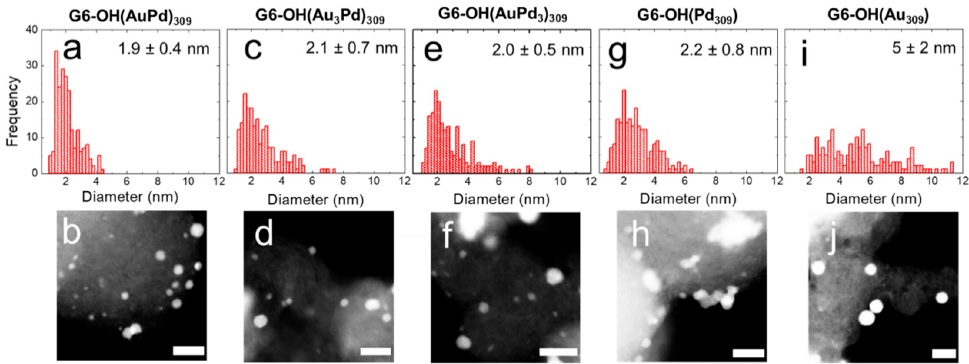
Figure 6. Size ‐ distribution histograms and ac ‐ STEM micrographs for conductive inks containing ( a , b ) G6-OH(AuPd) 309 ; ( c , d ) G6-OH(Au 3 Pd) 309 ; ( e , f ) G6-OH(AuPd 3 ) 309 ; ( g , h ) G6-OH(Pd 309 ); and ( i , j ) G6-OH(Au 309 ) DENs after electrocatalytic EOR CAs. CAs were carried out in a N 2 -satd., 1.0 M KOH solution containing 0.50 M ethanol, by holding the electrode potential for 1.0 h at the peak potential of the forward scan of the EOR CV. The scale bar is 10.0 nm.